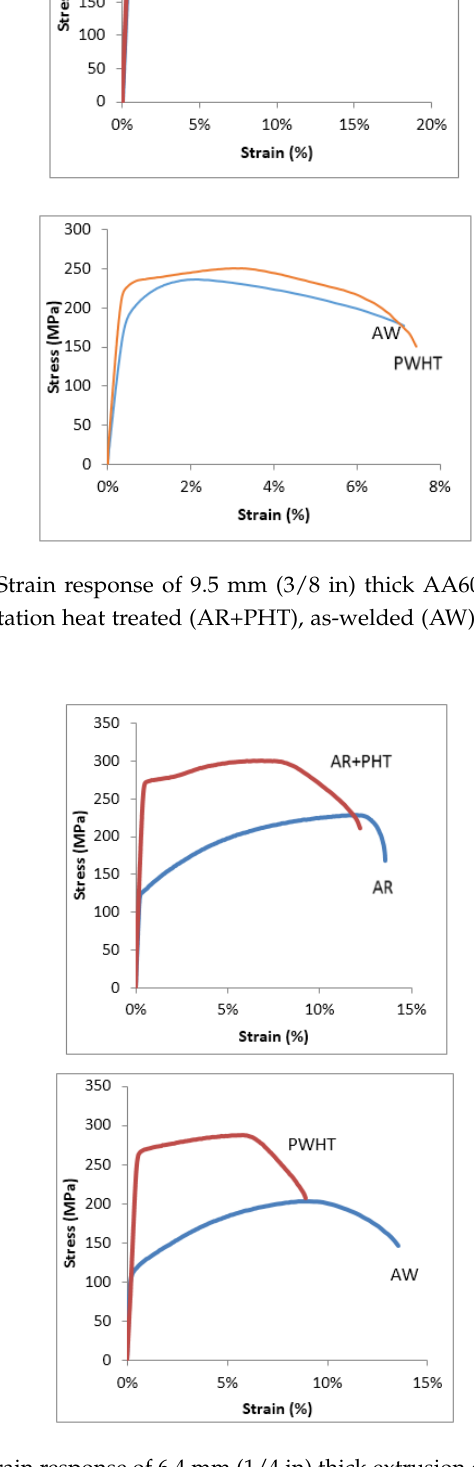
Figure 9. Stress versus strain response of 6.4 mm (1/4 in) thick extrusion of AA6061 in the as ‐ received (AR), as ‐ received plus precipitation heat treated (AR+PHT), as ‐ welded (AW), and post weld heat treated conditions.